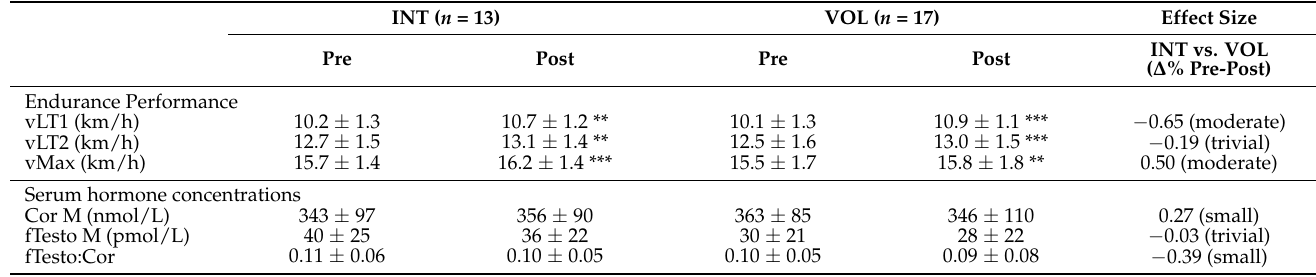
Table 3. Laboratory test results at the beginning (Pre) and the end (Post) of the training period.